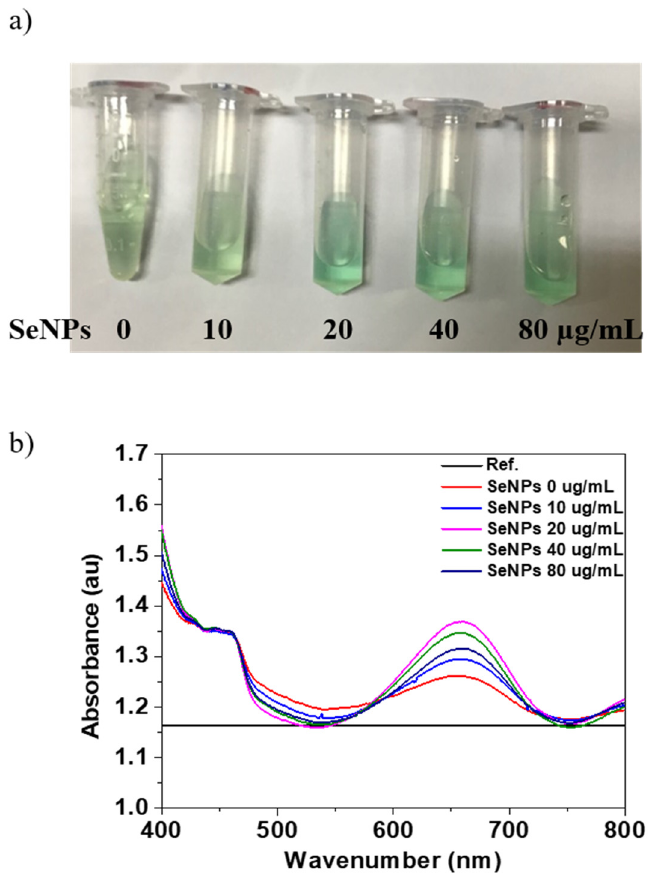
Figure 2. Determination of oxidase properties of different concentrations of SeNPs: ( a ) The color evaluation of TMB oxidation with SeNP concentrations of 0, 10, 20, 40, and 80 µ g/mL, ( b ) the UV-visible absorption spectra of TMB (before reaction as Reference) and after oxidation for 30 min with and without SeNPs.